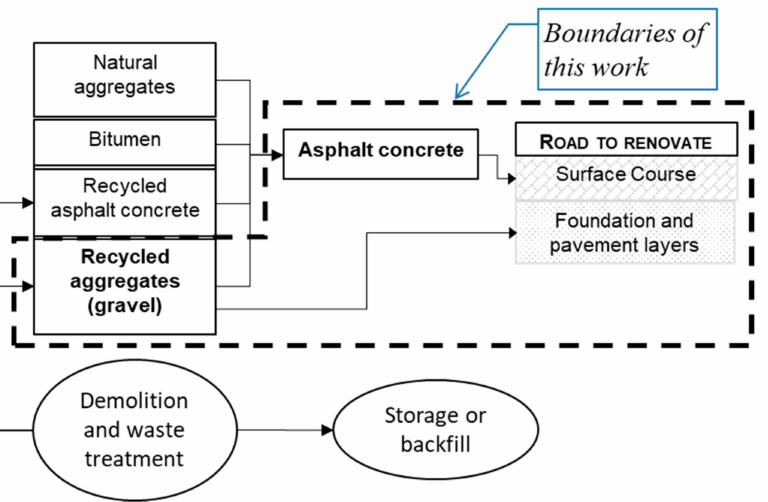
Figure 2. Boundaries of the work: focus on gravel and asphalt flows, used for road renovation applied to the PACA region. Source: [10] and this work.